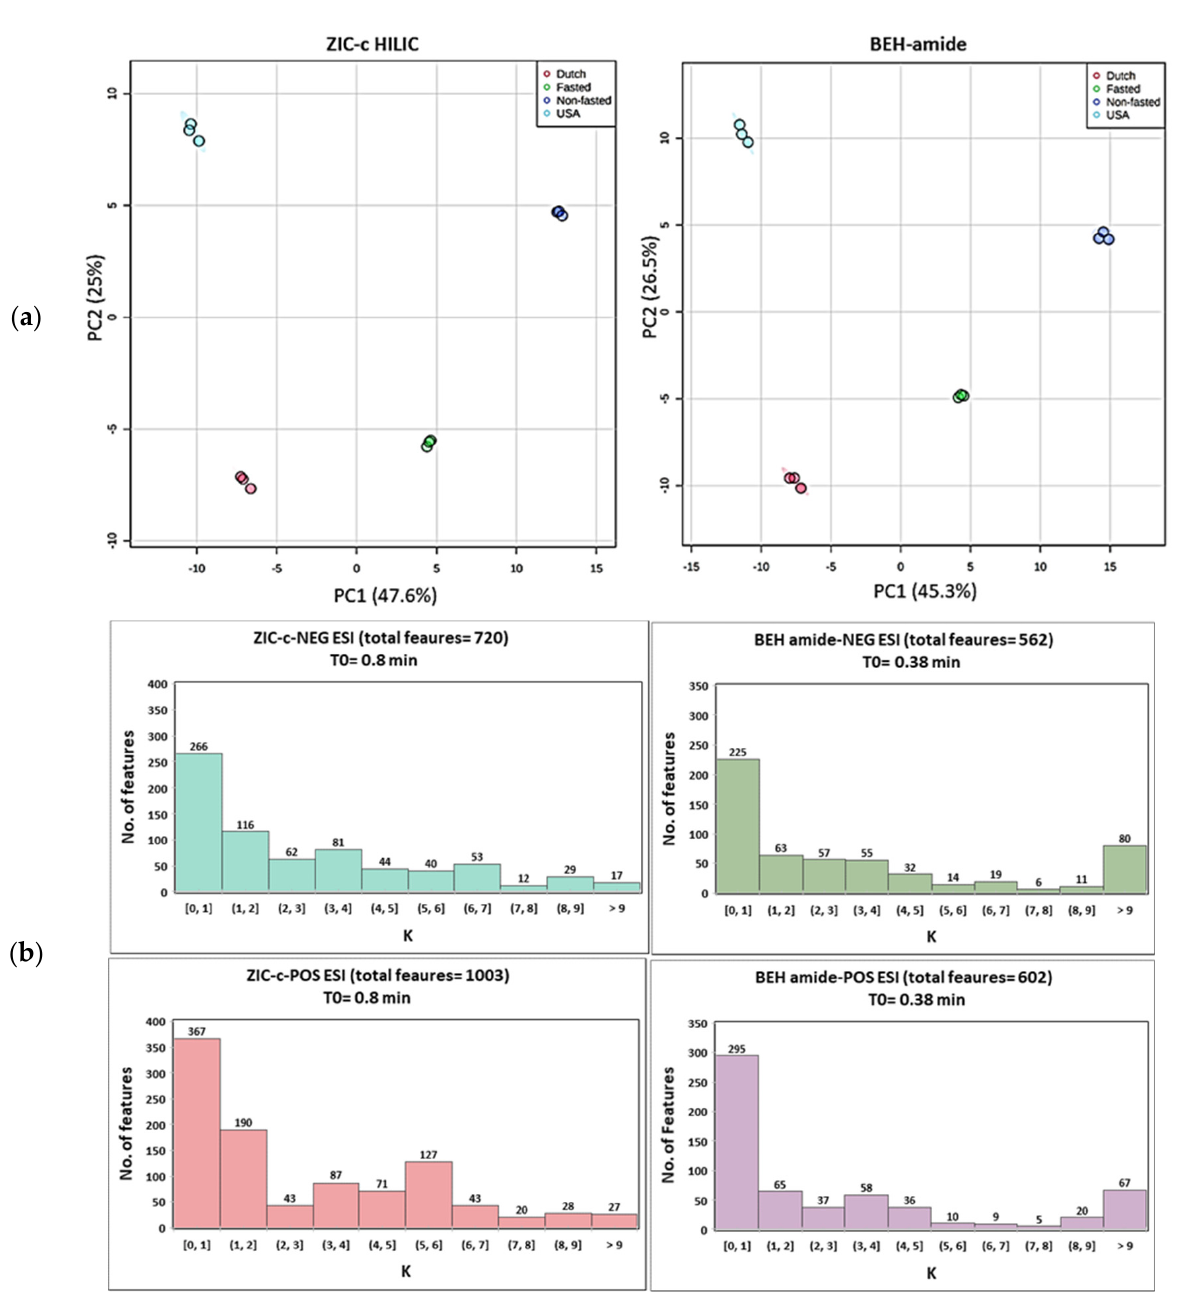
Figure 5. ( a ) Principal component analysis (PCA) score plot of pre-processed untargeted features in ZIC-c and BEH-amide. Each phenotype was subjected to a triplicate sample analysis; ( b ) Retention factor (K) distribution of detected features on each column.